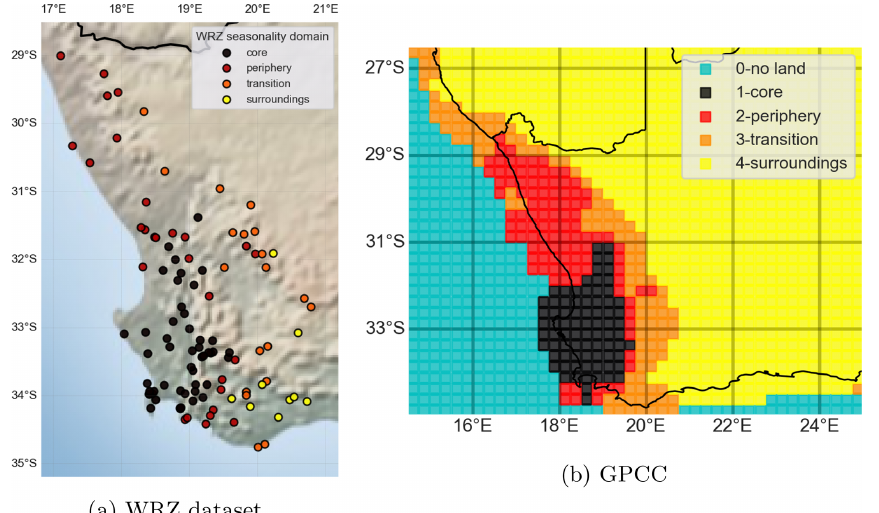
Figure A3. Figure 10a and c of Conradie et al. (2022): the simple seasonality domain classification in the WRZ and GPCC datasets.